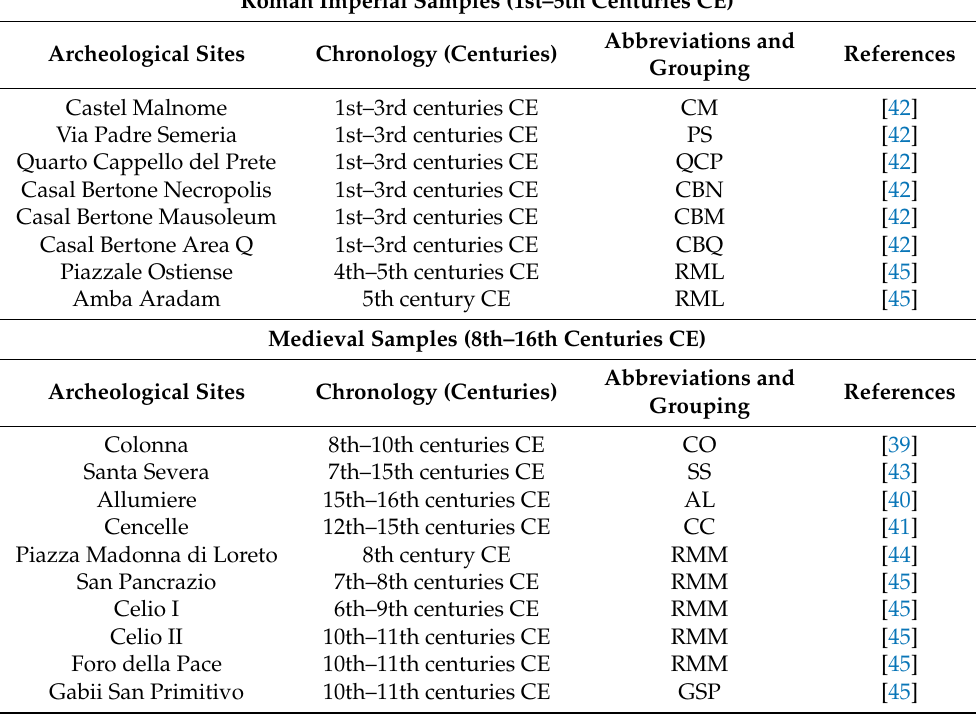
Table 2. Summary of the analyzed samples dating to Roman Imperial and Medieval periods. For each site chronology, abbreviation and references are